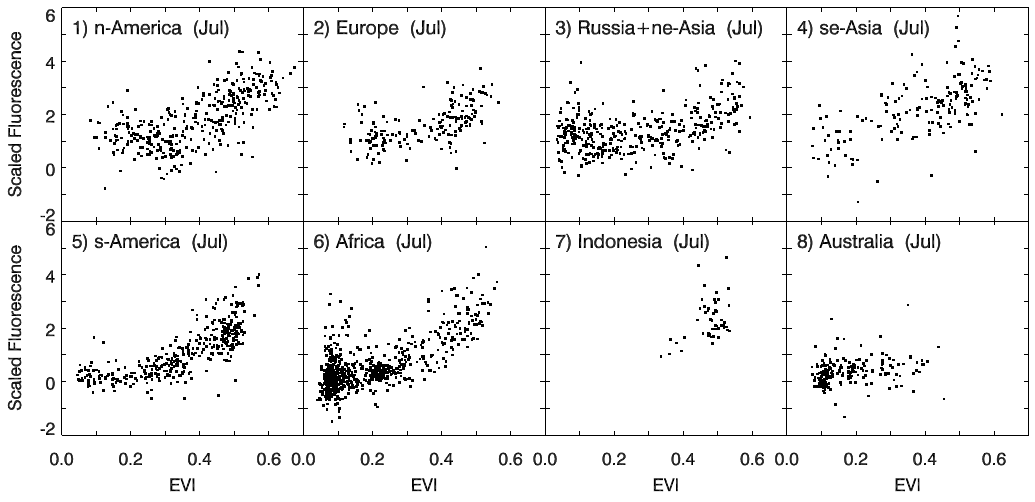
Fig. 14. Scatter plots of the GOSAT scaled F from the P polarization versus the MODIS enhanced vegetation index (EVI) (both unitless) for July 2009 for different regions shown in Fig. 11. Each point represents a monthly mean from a single 2 ◦ × 2 ◦ grid box.